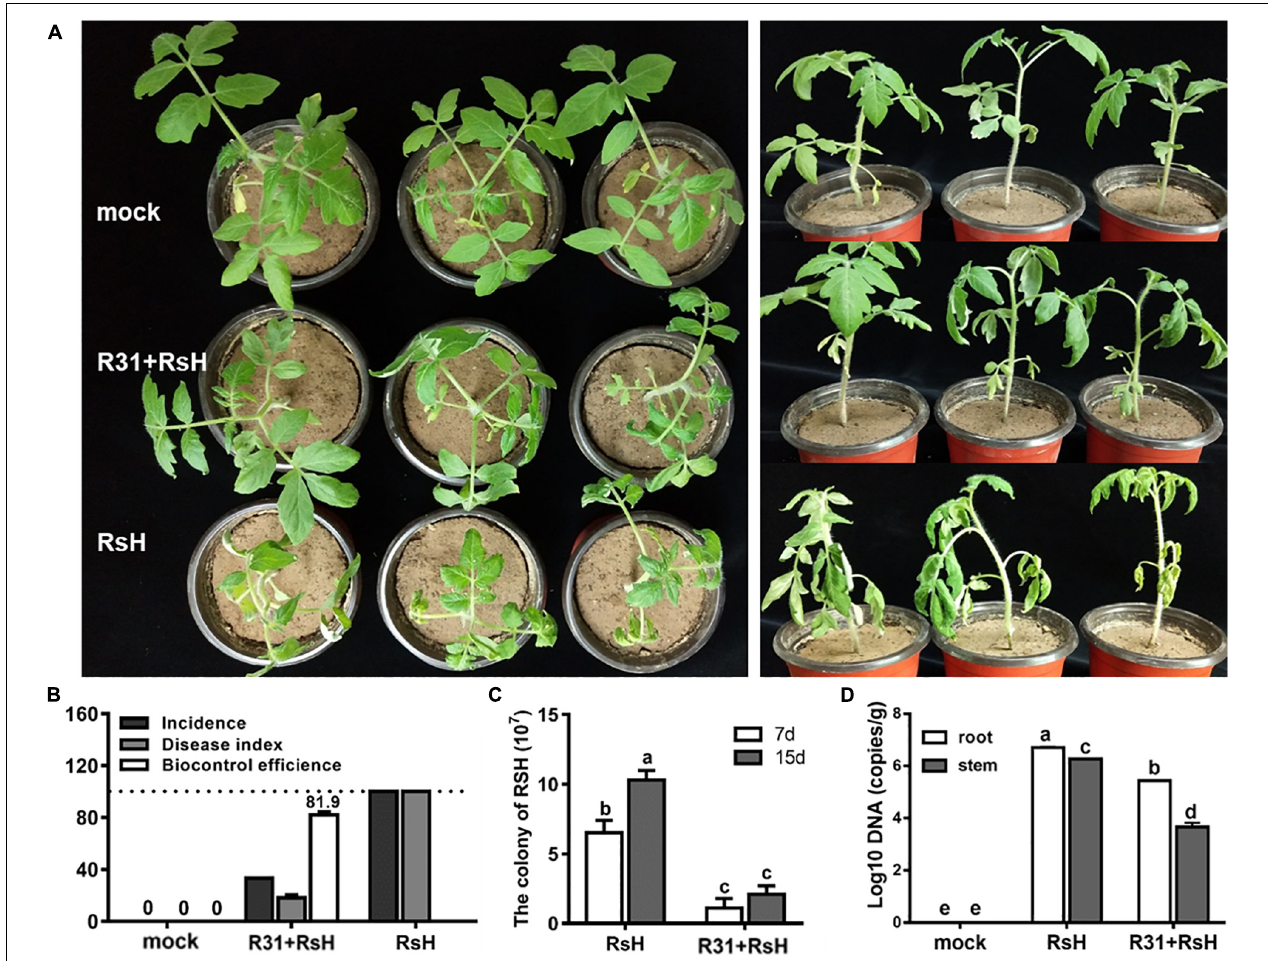
FIGURE 5 | Pot experiments assayed strain R31 suppressing TBW. (A) Greenhouse pot experiments of strain R31 for biocontrol of TBW, mock was a sterile water control, R31 + RsH was for simultaneous inoculated of strain R31 and RsH, and RsH was only inoculated with RsH. After continued cultivation for another 7 days, the treatments were photographed. The left and right panels show the top and the side views, respectively. (B) Biocontrol effect statistics of strain R31 against TBW, plant disease status was evaluated based on equation that is described in the “Materials and Methods” section. (C) The abundance of RsH was tested by counting the colony formation units. Each 10 g of soil was sampled from the tomato rhizospheres that were added only with RsH (RsH) and with strain R31 and RsH (R31 + RsH), respectively. After a 10-fold series dilution, the soil suspension was spread on TTC plate. Colony was counted after 2 days incubation. (D) Quantitative results of RsH in tomato root and stem tissues were obtained through RT-qPCR, uninoculated tomato root and stem tissues as a mock. Triplicate experiments were carried out, and the averages and standard deviations are shown. The lowercase letters at each bar top show the statistically significant differences by Duncan’s test ( p <